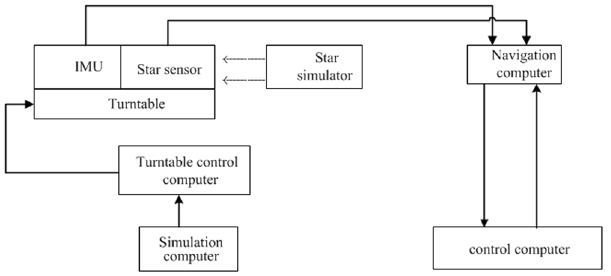
Figure 2. The experimental principle of calibration for the stellar-inertial integrated